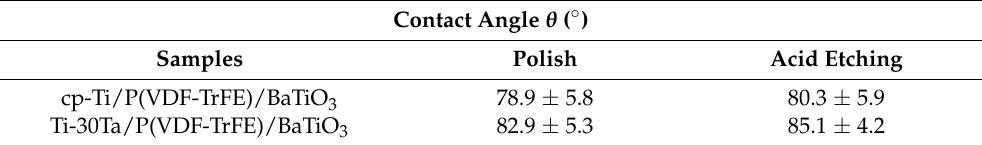
Table 9. Wettability of the cp-Ti and Ti-30Ta coated